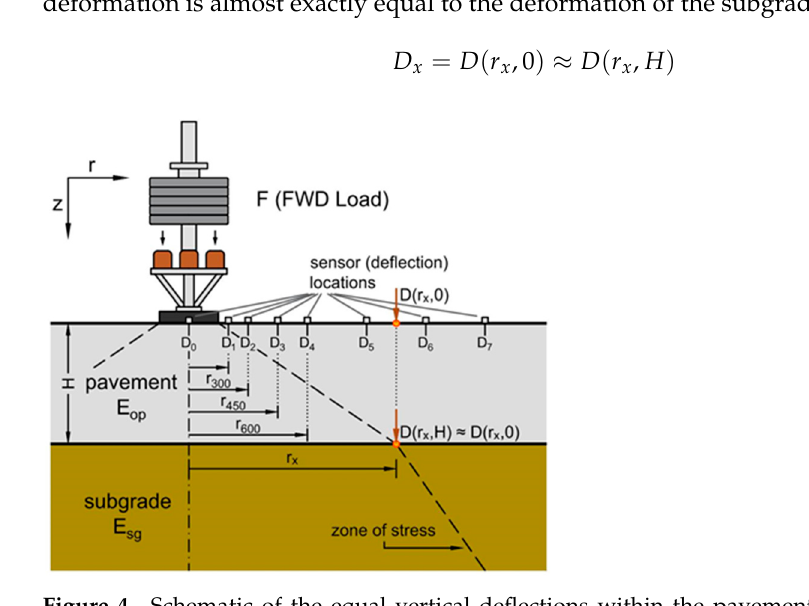
Figure 4. Schematic of the equal vertical deflections within the pavement system under FWD loading [13].